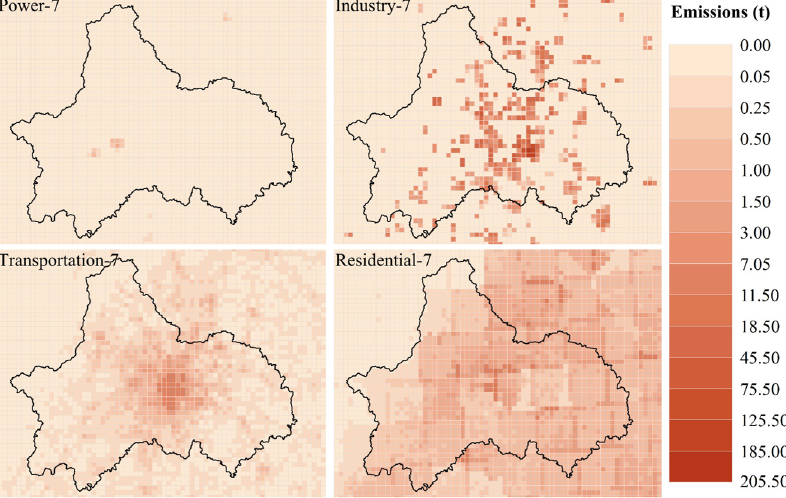
Figure 7. PM 2.5 emission distribution of power, industry, residential and transportation sectors in Chengdu, July 2017.